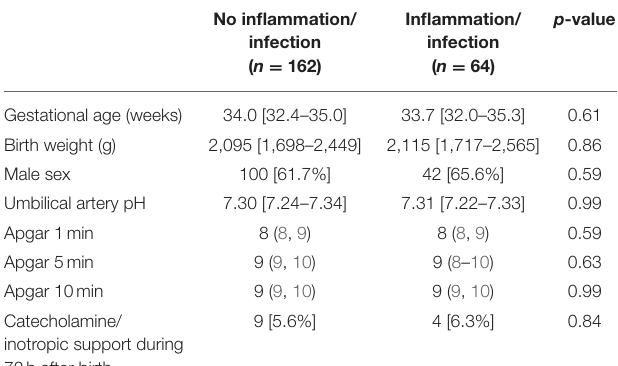
TABLE 1 | Demographic and clinical data of healthy preterm neonates and those with early inflammation/infection: median and interquartile range [25 th and 75 th percentile] or relative